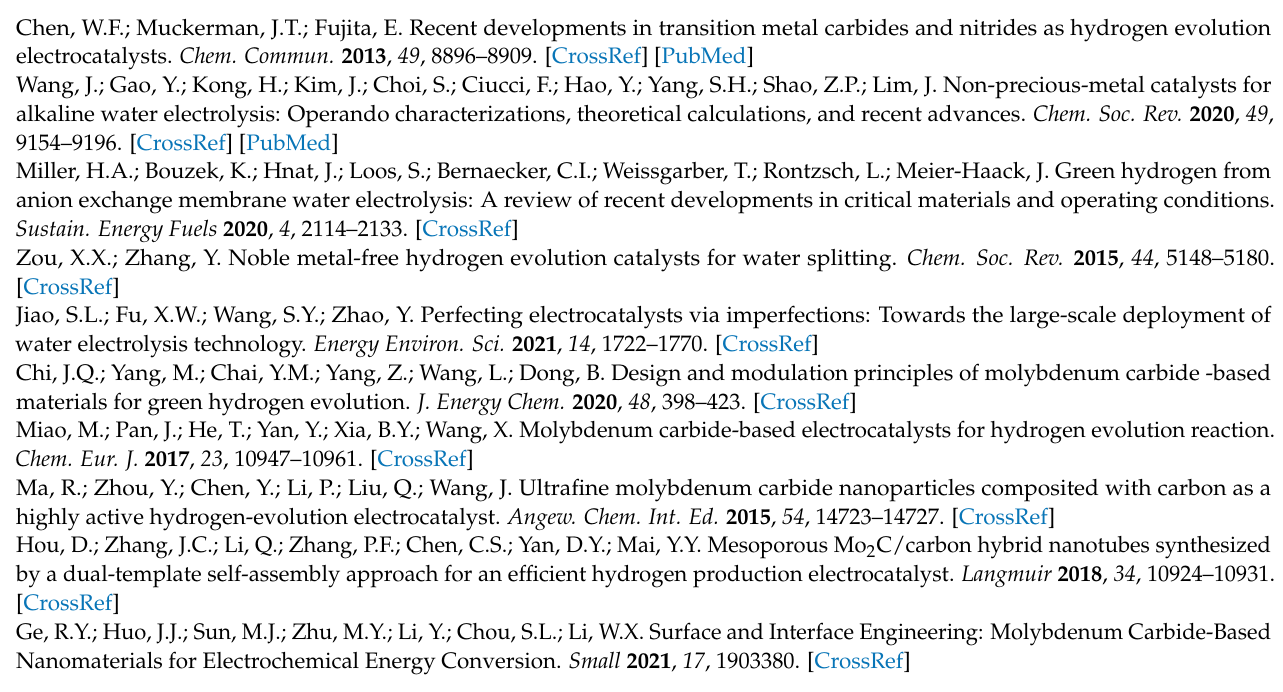
Figure S2: SEM image and corresponding elemental distributions; Figure S3: (a) Polarization curves and (b) capacitive plots at 0.15 V of catalysts in 0.5 M H 2 SO 4 solution; Figure S4: (a) Polarization curves and (b) capacitive plots at 0.15 V of catalysts in 0.5 M H 2 SO 4 solution; Figure S5: Catalytic stability test of 250-800-2h catalyst at − 0.15 V in 0.5 M H 2 SO 4 solution; Table S1: Comparison of